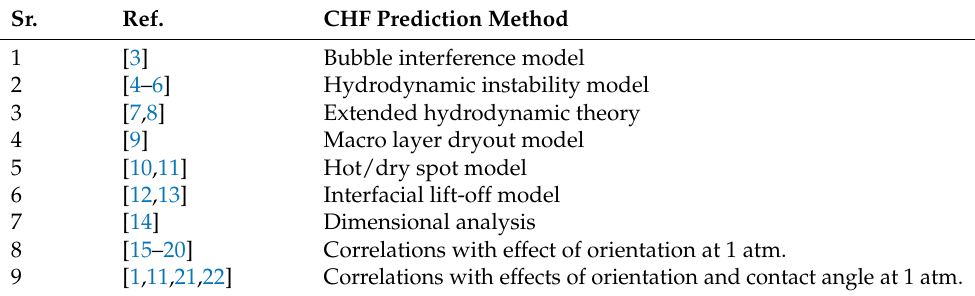
Table 1. Literature review on prediction methods of pool-boiling CHF. Sr.